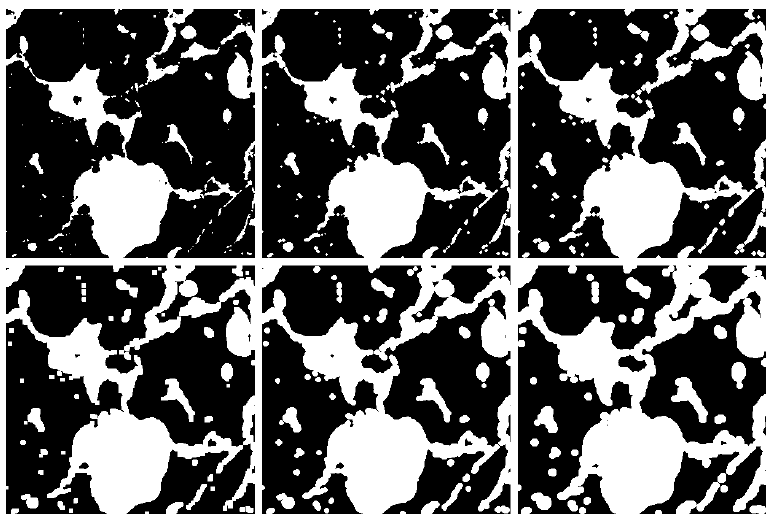
Figure A2. An example of morphological dilatation operation applied with structural units of different sizes for images of samples from the arable soil horizon. Voids are white and solid phase is black.